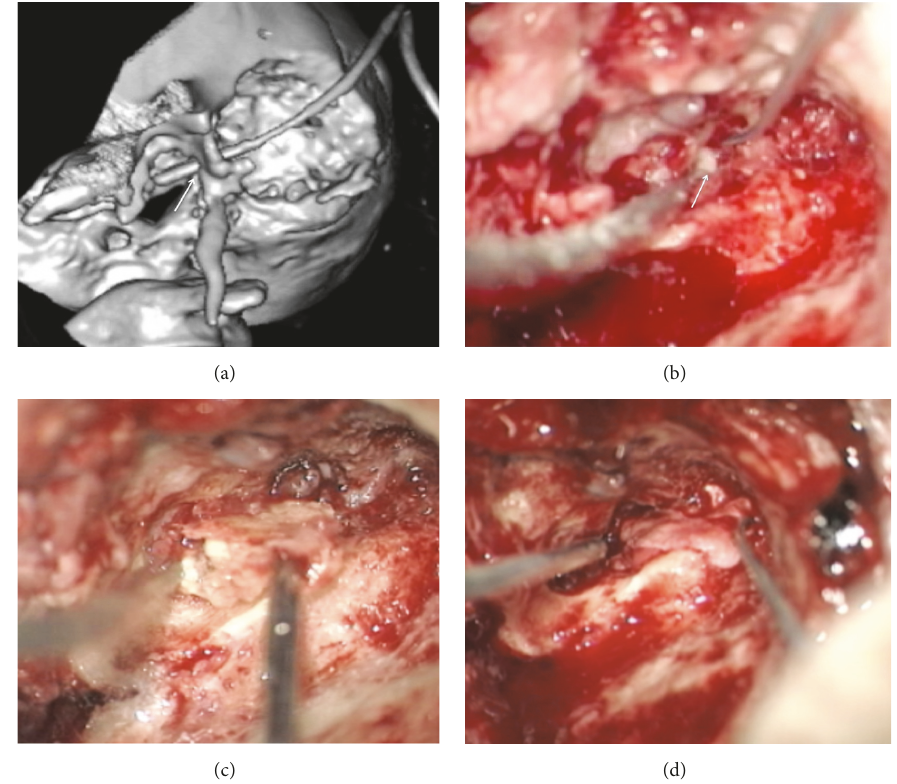
Figure 3: (a) A 3D volume rendering scan shows the amount of bone removed during lateral petrosectomy. The drain was inserted into the abscess cavity through the defect in the anterior EAC wall (arrow). (b) Intraoperative image: a defect in the anterior wall of the tympanic cavity (arrow). Pus under the pressure appeared when the granulations were removed from the tympanic cavity. (c) After the tympanic part of the temporal bone was partially drilled, a large bony sequestrum was removed with microforceps. (d) Finally, the third type of tympanoplasty was carried out.